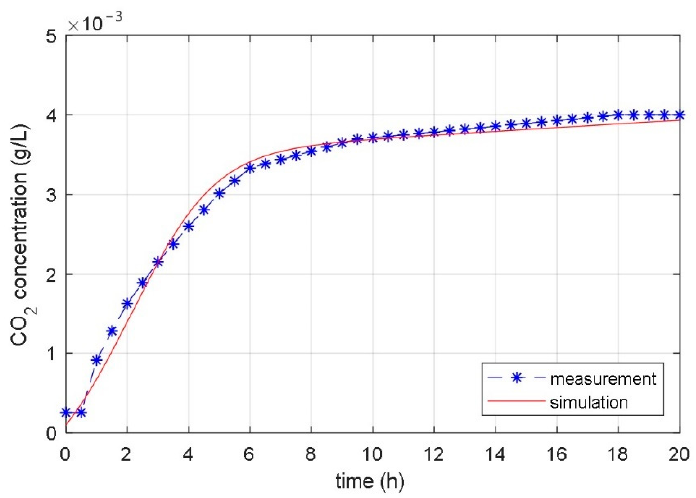
Figure 13. Measured and simulated time courses of the CO 2 concentration during the fermentation process with constant bioreactor temperature 22 °C.